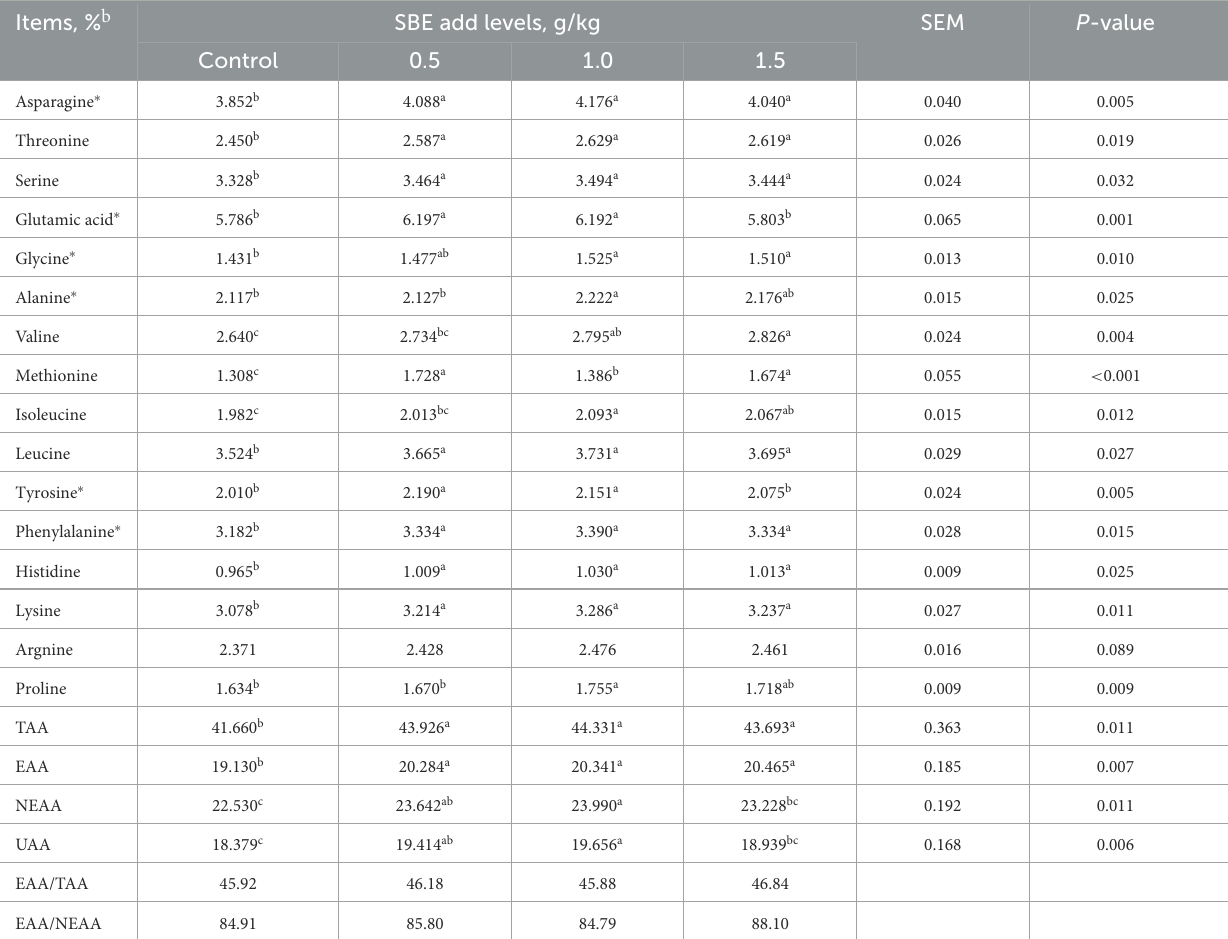
TABLE 5 Effect of dietary SBE on amino acids in eggs a . Items, %